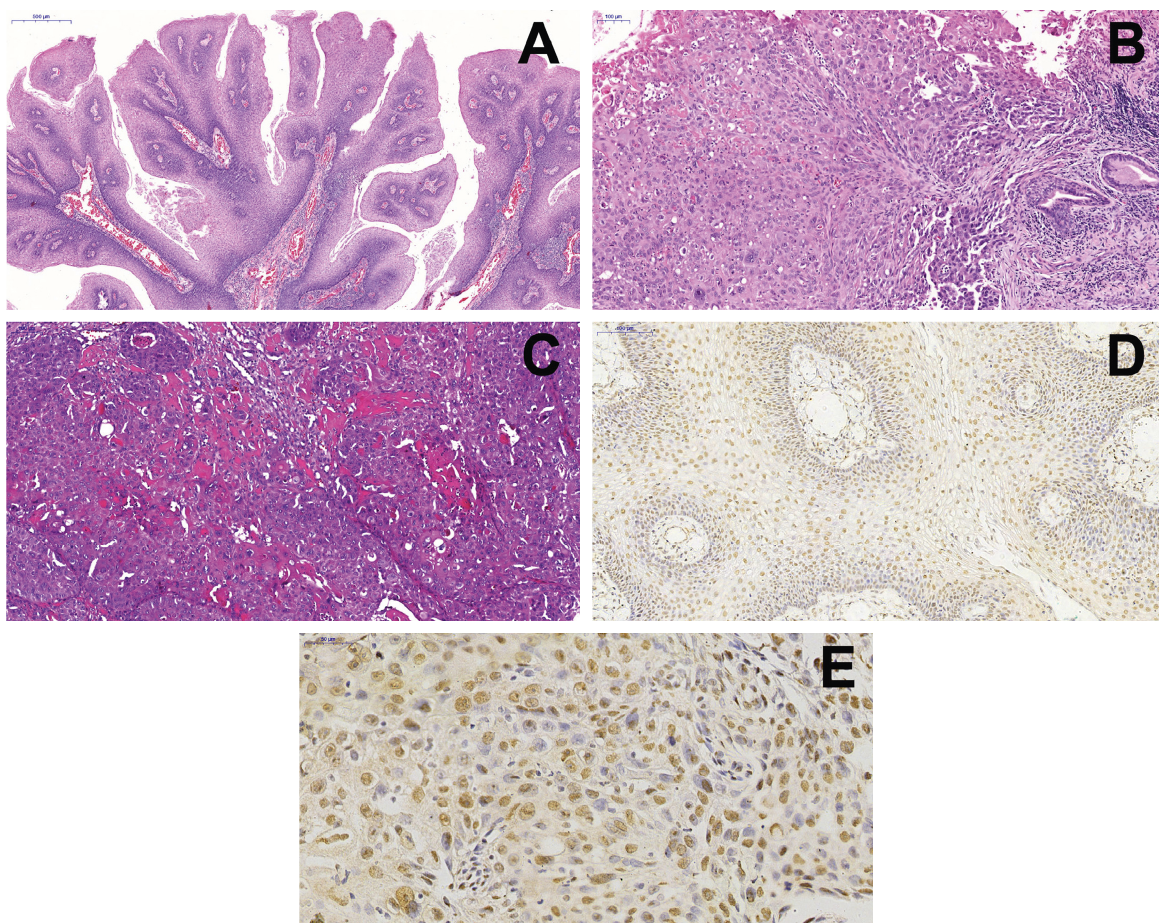
Figure 1: Photomicrographs: lesion with papillary appearance showing exophytic projections of epithelial proliferation with benign appearance (a), transition zone of malignant neoplasm in the right vocal fold (b), well-differentiated SCC (c), dotted brown nuclei showing positive CISH result for high-risk HPV (16/18) in LP (d), and in SCC